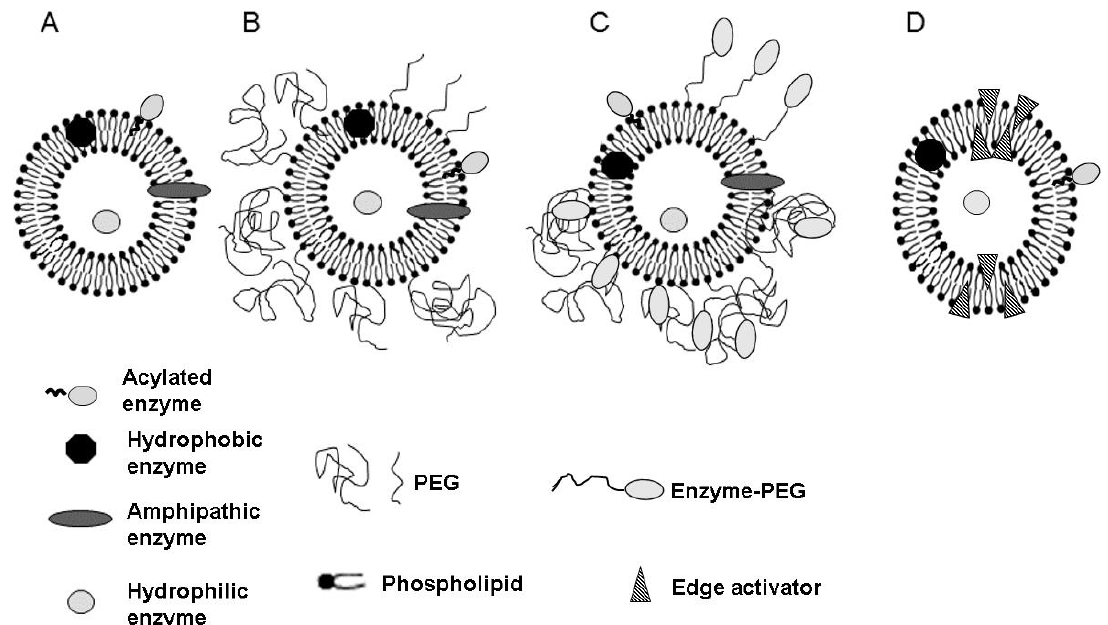
Figure 1. Schematic representation of different types of liposomes: ( A )—Conventional liposome loaded with hydrophilic enzyme in the internal aqueous space, and hydrophobic, amphipathic and acylated (hydrophilic enzyme linked to fatty acid chains) enzymes in the lipid bilayer; ( B )—Enzyme-loaded liposomes containing lipids linked to polyethylene glycol (PEG), called long-circulating liposomes; ( C )—Enzyme-loaded liposomes containing simultaneously PEG and enzymes at liposome surface or linked to functionalized PEG; ( D )—Enzyme-loaded ultra-deformable liposomes, Transfersomes), with the non-uniformly distributed edge-active components at the stressed sites for membrane deformation. Vesicle D was intentionally drawn in an oval shape to represent the deformity that characterizes it and that is caused by the edge activator molecules. Adapted from Torchilin et al. 2005 [35].